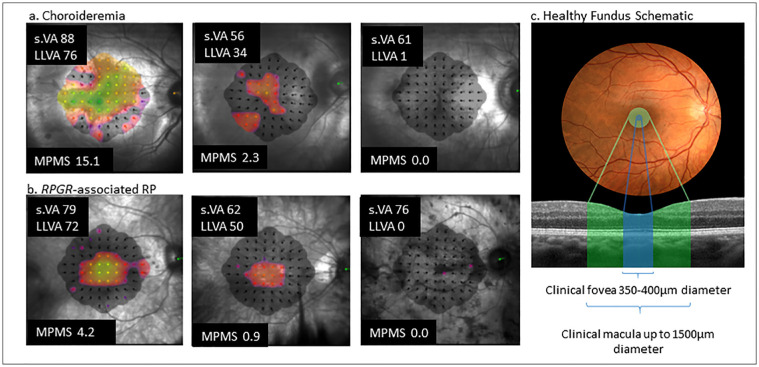
(a) Microperimetry plot results, standard VA (s.VA) and LLVA for three patients with choroideremia with a range of central retinal sensitivity function to represent different disease stages. The brighter color the threshold sensitivity map, the greater the central function; the darker red, purple, and black areas indicate reducing sensitivity function. (b) RPGR-associated RP microperimetry results with standard VA and LLVA of three patients with a range of central retinal sensitivity function representing different disease stages. (c) A schematic diagram to illustrate the clinical definitions of the extent of the foveal and macular areas. MPMS, microperimetry mean sensitivity.